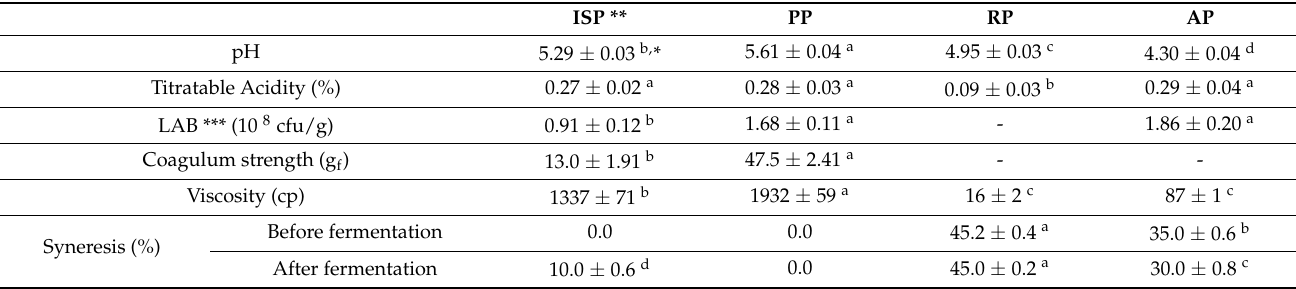
Table 2. Fermentation characteristics of various plant proteins (5%, w / w